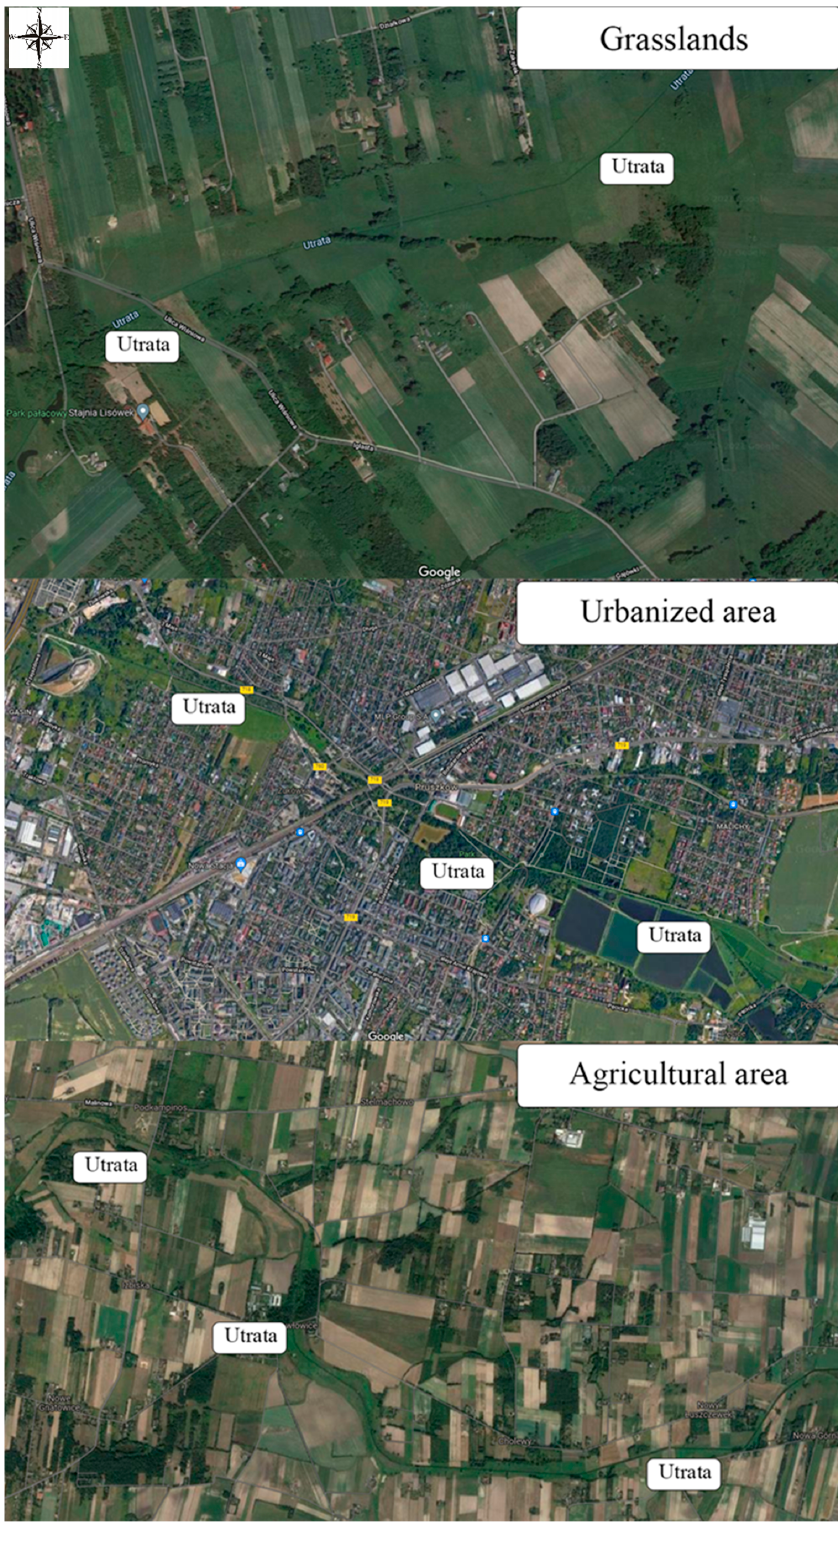
Figure 1. Study area—land use